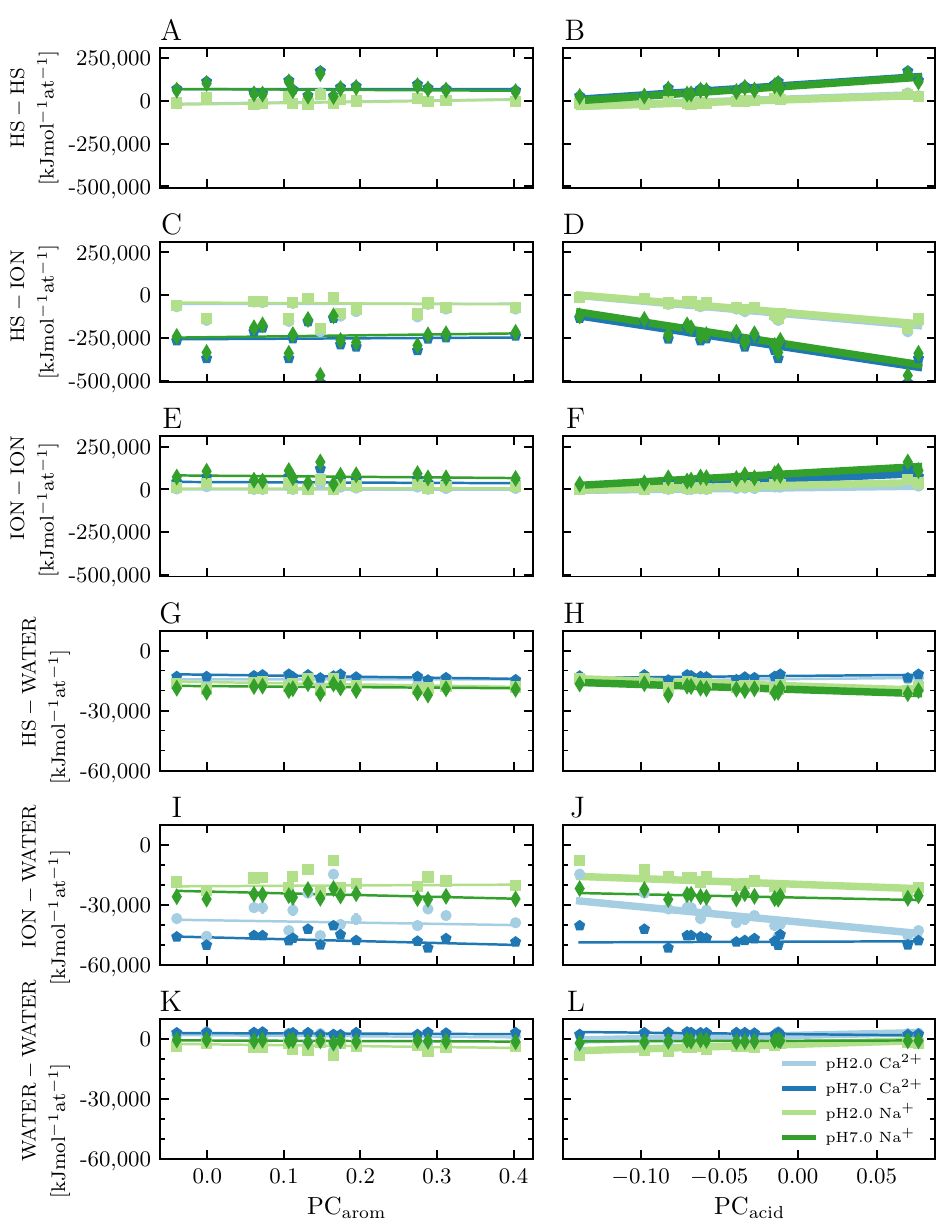
Figure 3. Nonbonded interaction between different species (HS, H 2 O and Ca 2 + ) of the standard hu- mic substances models. ( A , B ) Nonbonded interactions between humic substances. ( C , D ) Nonbonded interactions between humic substances and cations. ( E , F ) Nonbonded interactions between cations. ( G , H ) Nonbonded interactions between humic substances and water molecules. ( I , J ) Nonbonded interactions between cations and water molecules. ( K , L ) Nonbonded interactions between water molecules. Each point represents the average over four independent simulations, with error bars representing the standard error. Each plot has fitted lines using weighted linear regression, which are presented as a tick line if the R 2 is larger than 0.6. Notice the different y -axis scales in these